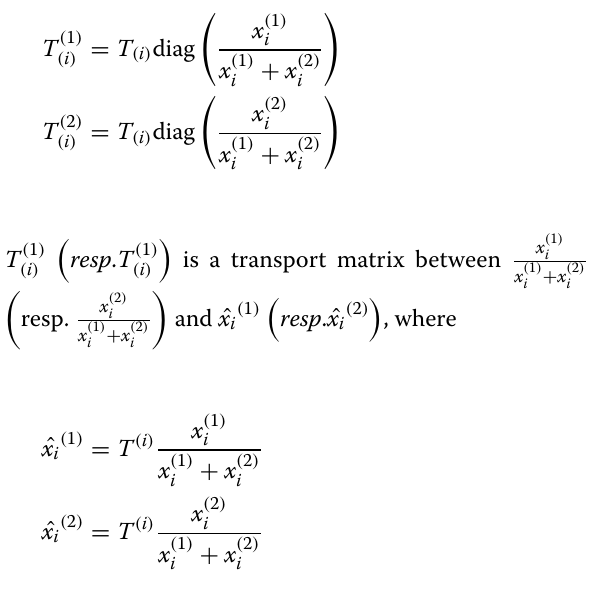
spectrum, X ( 1 ) and X ( 2 ) the separated spectra such that X ≈ X ( 1 ) + X ( 2 ) . The Wiener filter builds ˆ X ( 1 ) X ( 2 ) = X (cid:12) X and X ( 1 ) + X ( 2 )